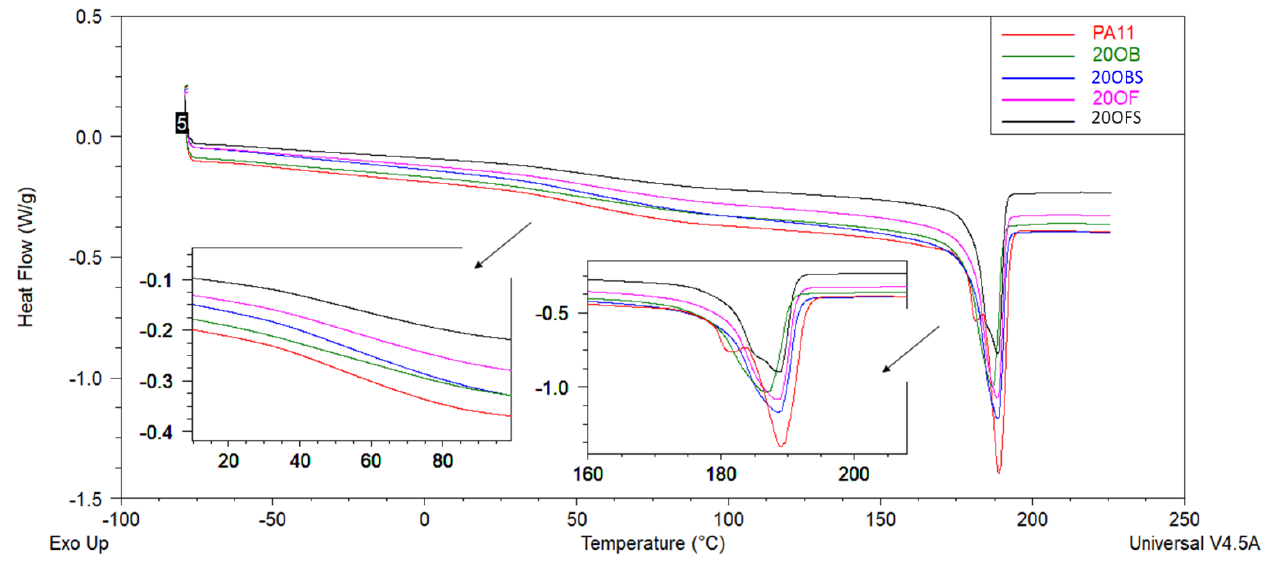
Figure 14. DSC curves of unmodified PA11 and composites, first heating; samples with 20% of diatoms.